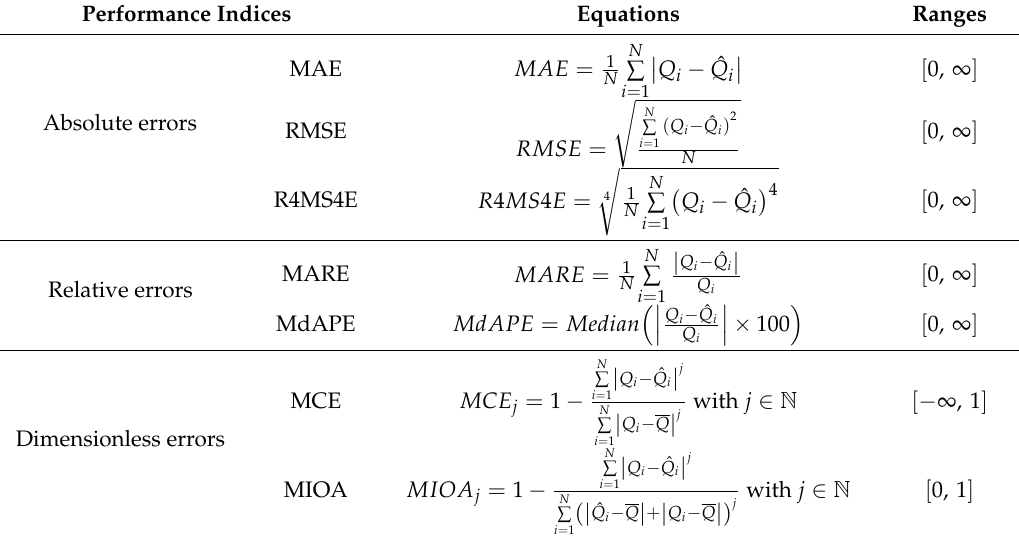
Table 2. Mathematical expressions and ranges for performance